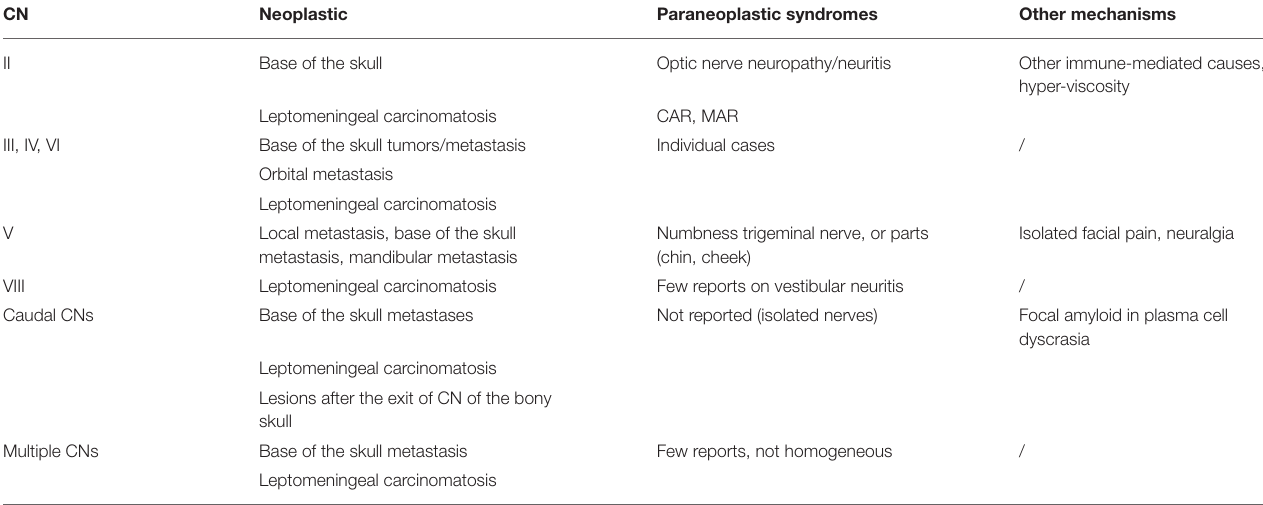
TABLE 6 | Paraneoplastic involvement of cranial